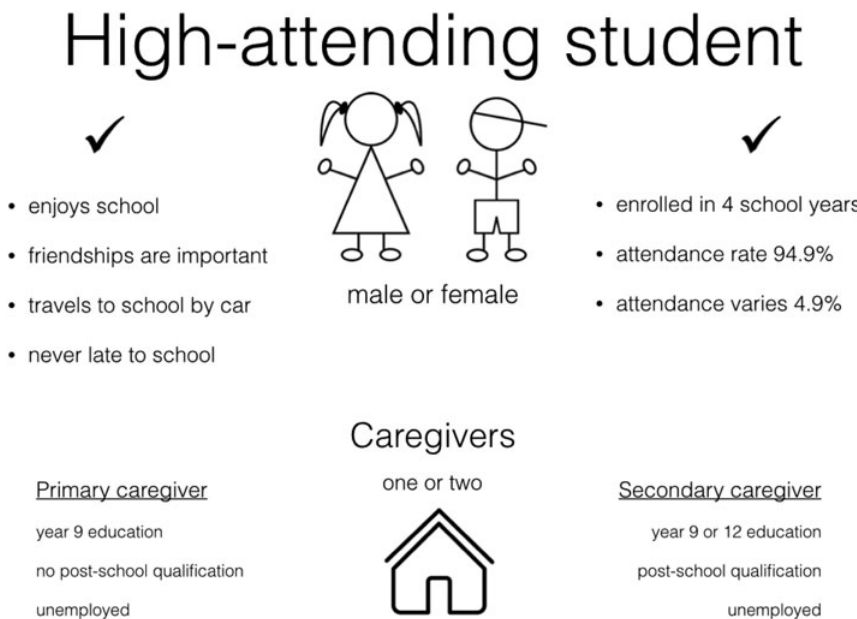
Fig. 1. Profile of a ‘ typical ’ high-attending Indigenous student enrolled at Watney in 2015, showing student and caregiver characteristics.